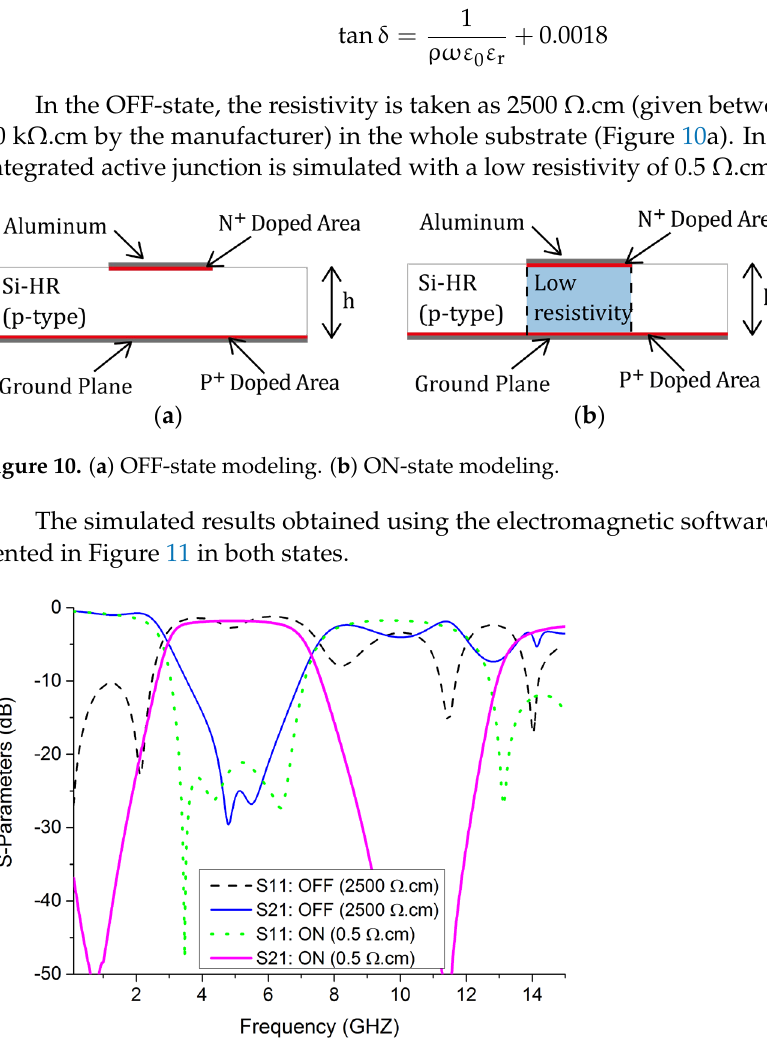
Figure 11. Simulated results in both states.